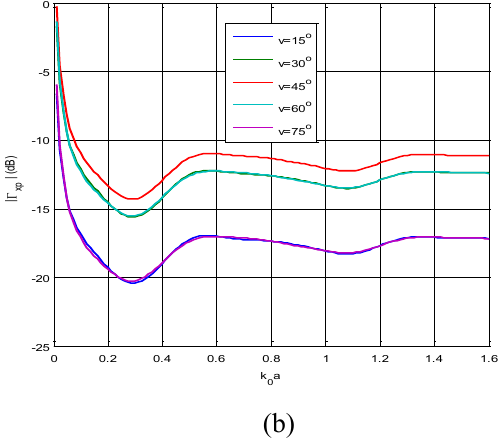
a for buried PEMC 0  =2.0, v = r